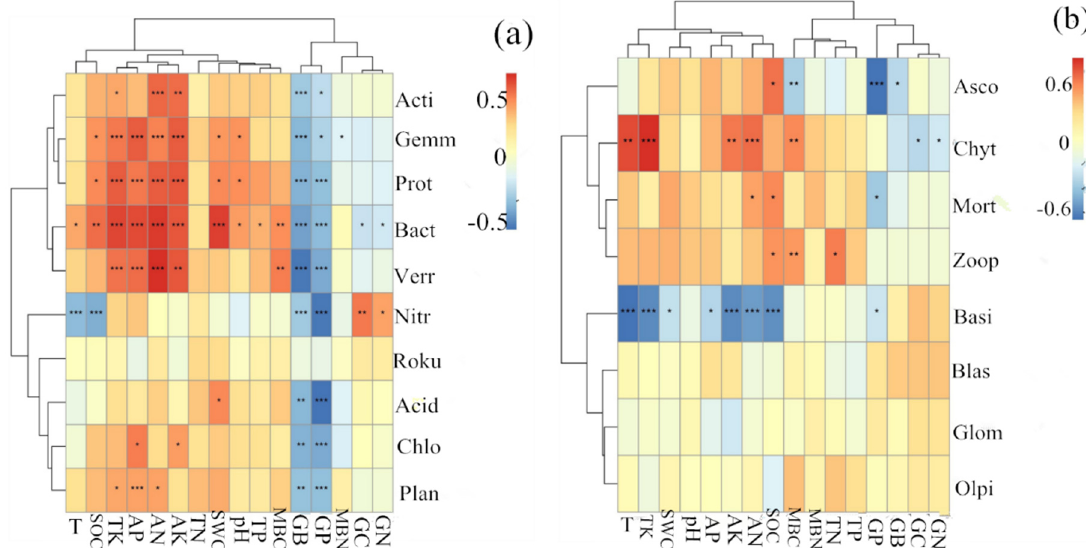
Figure 4. Spearman’s rank correlation coefficients describing the relationships between the soil properties, cover grass properties and microbial community compositions. T indicates temperature, SWC indicates soil water content, SOC indicates soil organic carbon, AN indicates available nitrogen, TN indicates total nitrogen, TP indicates total phosphorus, AP indicates available phosphorus, AK indicates available potassium, TK indicates total potassium, MBC indicates microbial biomass carbon, MBC indicates microbial biomass nitrogen, GB indicates cover grass biomass, GC indicates cover grass carbon, GN indicates cover grass nitrogen, and GP indicates cover grass phosphorus. ( a ) indicates the bacterial community and ( b ) indicates the fungal community. Prot indicates Proteobacteria, Acid indicates Acidobacteria, Acti indicates Actinobacteria, Chlo indicates Chloroflexi, Gemm indicates Gemmatimonadetes, Bact indicates Bacteroidetes, Plan indicates Planctomycetes, Roku indicates Rokubacteria, Nitr indicates Nitrospirae, Verr indicates Verrucomicrobia. Asco indicates Ascomycota, Chyt indicates Chytridiomycota, Mort indicates Mortierellomycota, Basi indicates Basidiomycota, Zoop indicates Zoopagomycota, Blas indicates Blastrociadiomycota, Glom indicates Glomeromycota, Olpi indicates Olpidiomycota. *** ( p < 0.001), ** ( p < 0.01) and * ( p < 0.05).